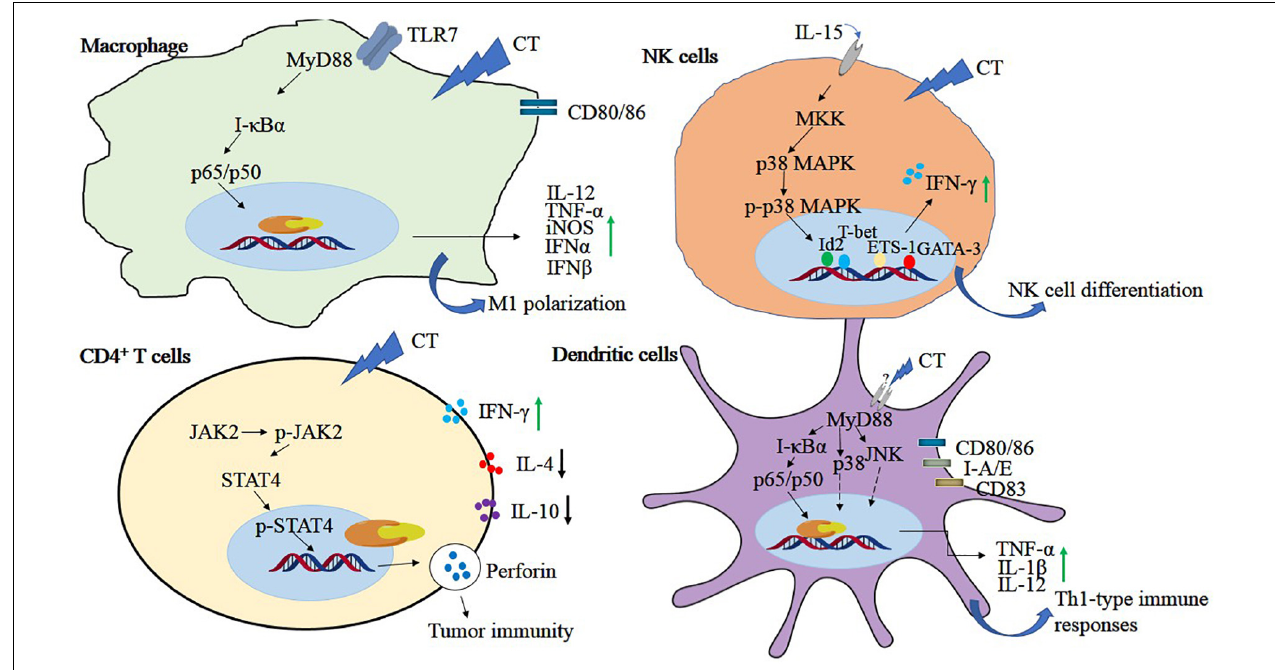
FIGURE 4 | The antitumor immune mechanisms of CT in different cells. Cryptotanshinone plays a role in tumor immunity by regulating NF- κ B, MAPK, JAK, and STAT4 signals in immune-related cells, including macrophage, NK cells, CD4 + T cells, and dendritic